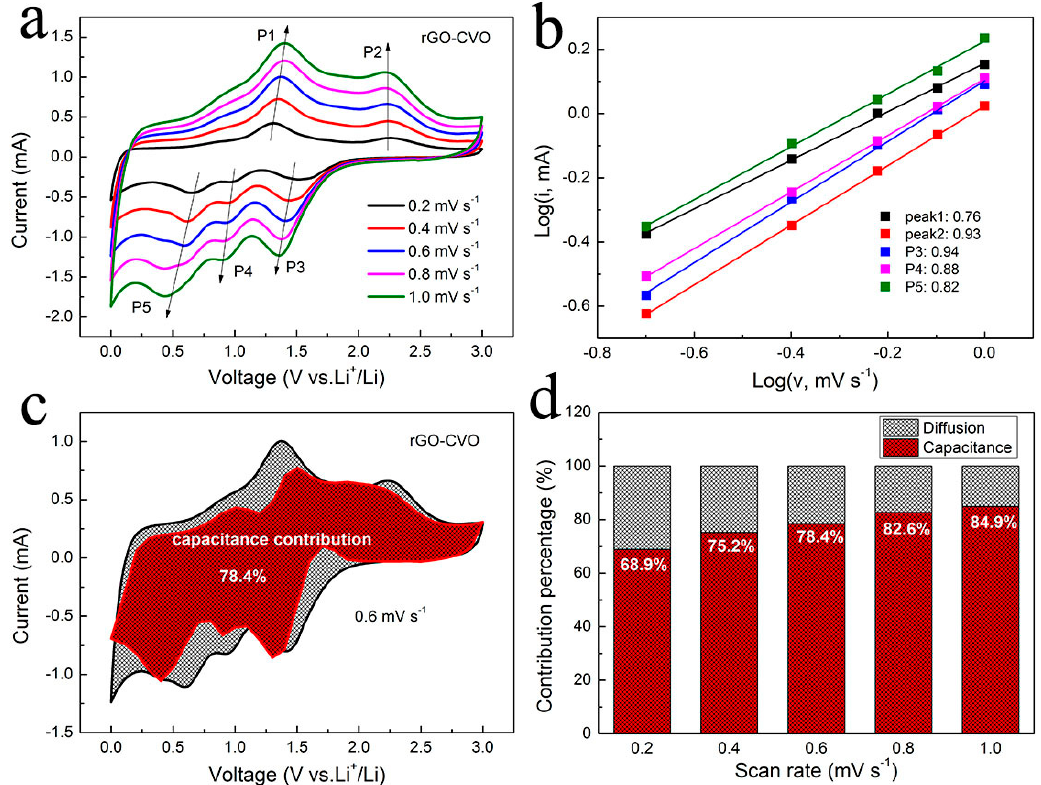
Figure 5. Kinetic analysis for lithium storage of rGO@CVO electrode: ( a ) CV curves at various scan rates; ( b ) log( i ) vs. log( v ) plots at each redox peaks. ( c ) Capacitive and diffusion-controlled contributions of rGO@CVO electrode at scan rate of 0.6 mV s − 1 ; ( d ) pseudocapacitive contribution ratio at different sweep rates of rGO@CVO electrode.